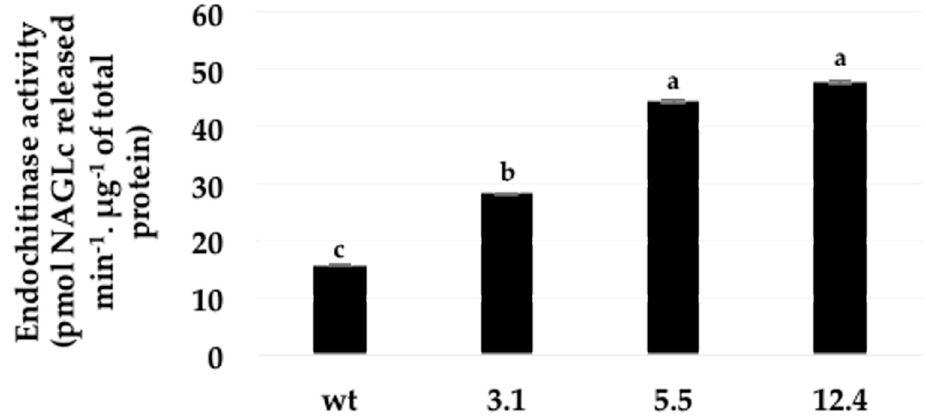
Figure 4. Endochitinase activity in crude leaves extracts of three different transgenic lines and untransformed (wt) plant. Error bars indicate standard deviation of means (SD). Within each frame different letters indicate statistically significant differences among transgenic lines ( p = <0.0001), n = 4.